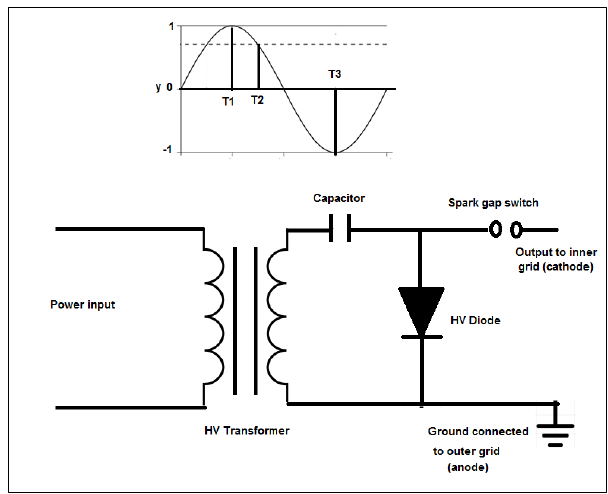
Figure 2. Circuit diagram of the power supply